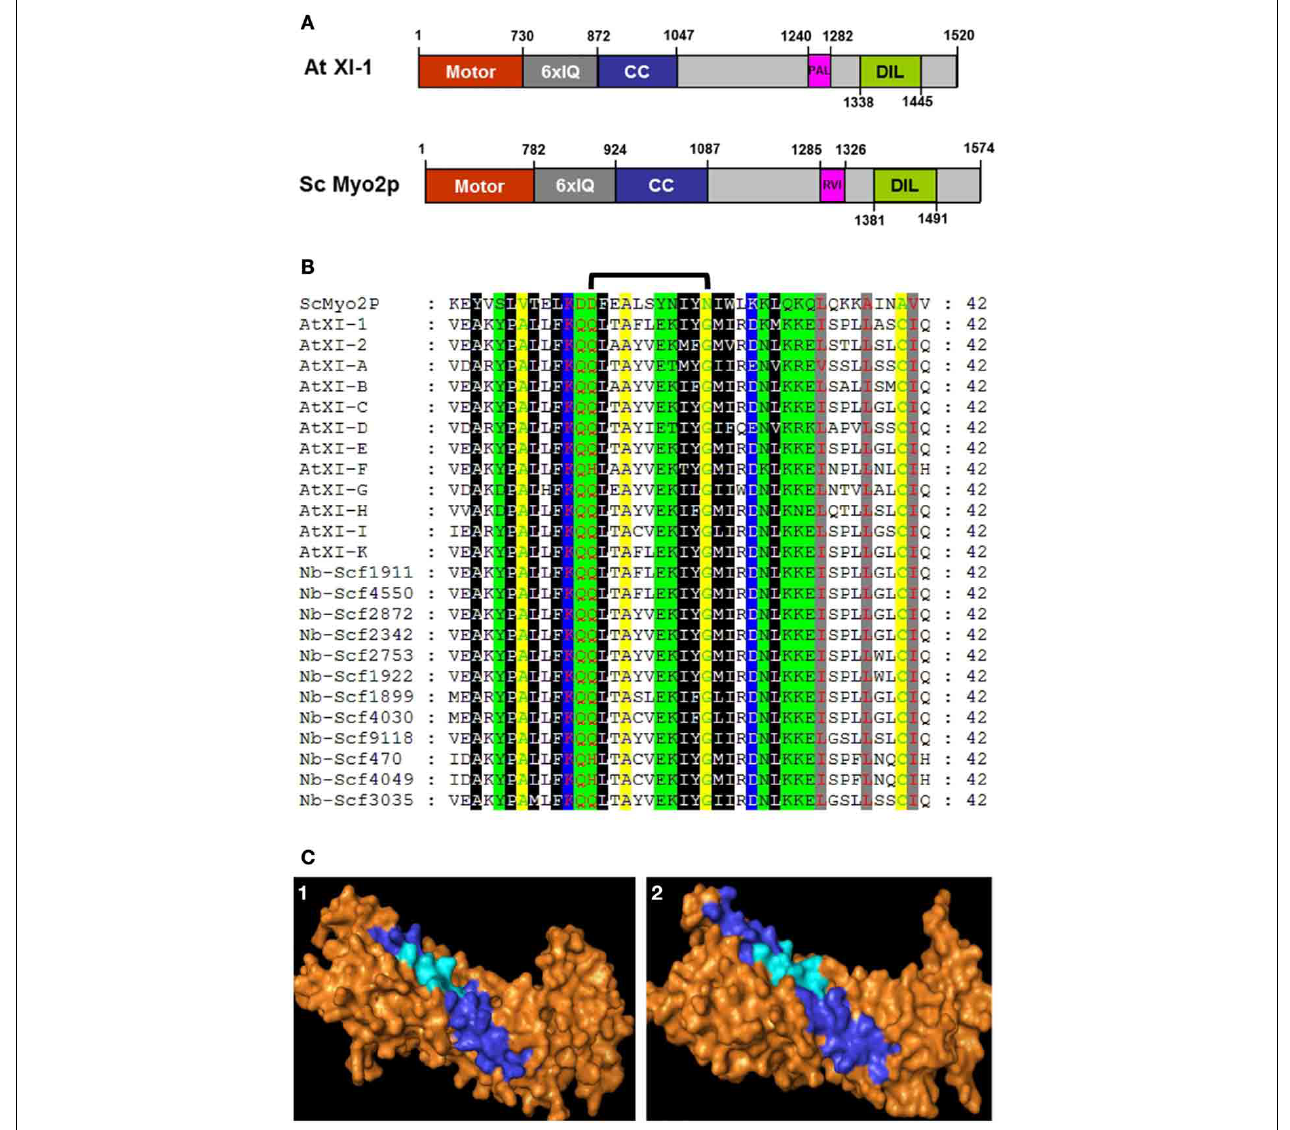
FIGURE 1 | Comparison of At XI-1 and yeast myo2p. (A) Diagram of A. thaliana myosin At XI-1 and yeast myosin V ScMyo2p. Motor domain, IQ repeats,coiled-coil(CC)regionsanddomainsinglobulartailofbothproteinsare shown. The PAL sub-domain, the cargo binding site from At XI-1 identified as homologous to ScMyo2p vacuole binding site (signified with RVI), and DIL domains are shown. Drawn approximately to scale except for the motor domain. (B) Alignment of the PAL sub-domains from A. thaliana class and N. benthamiana XI myosins to the homologous domain in the yeast Sc Myo2p.